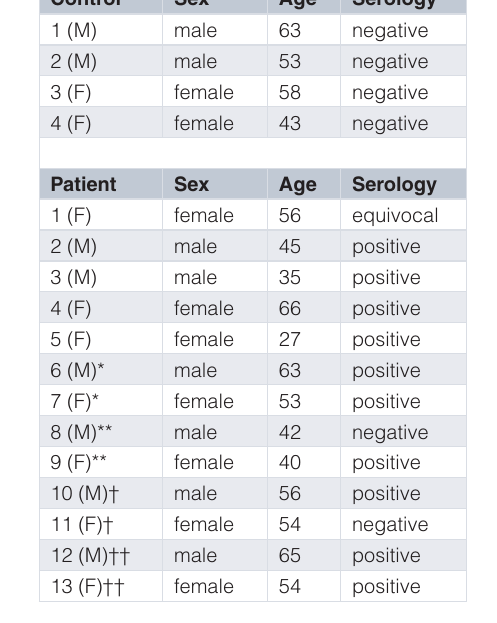
Table 2. Microscopy results from fresh blood and genital culture fluid. See Dataset, data file 1. ND, not